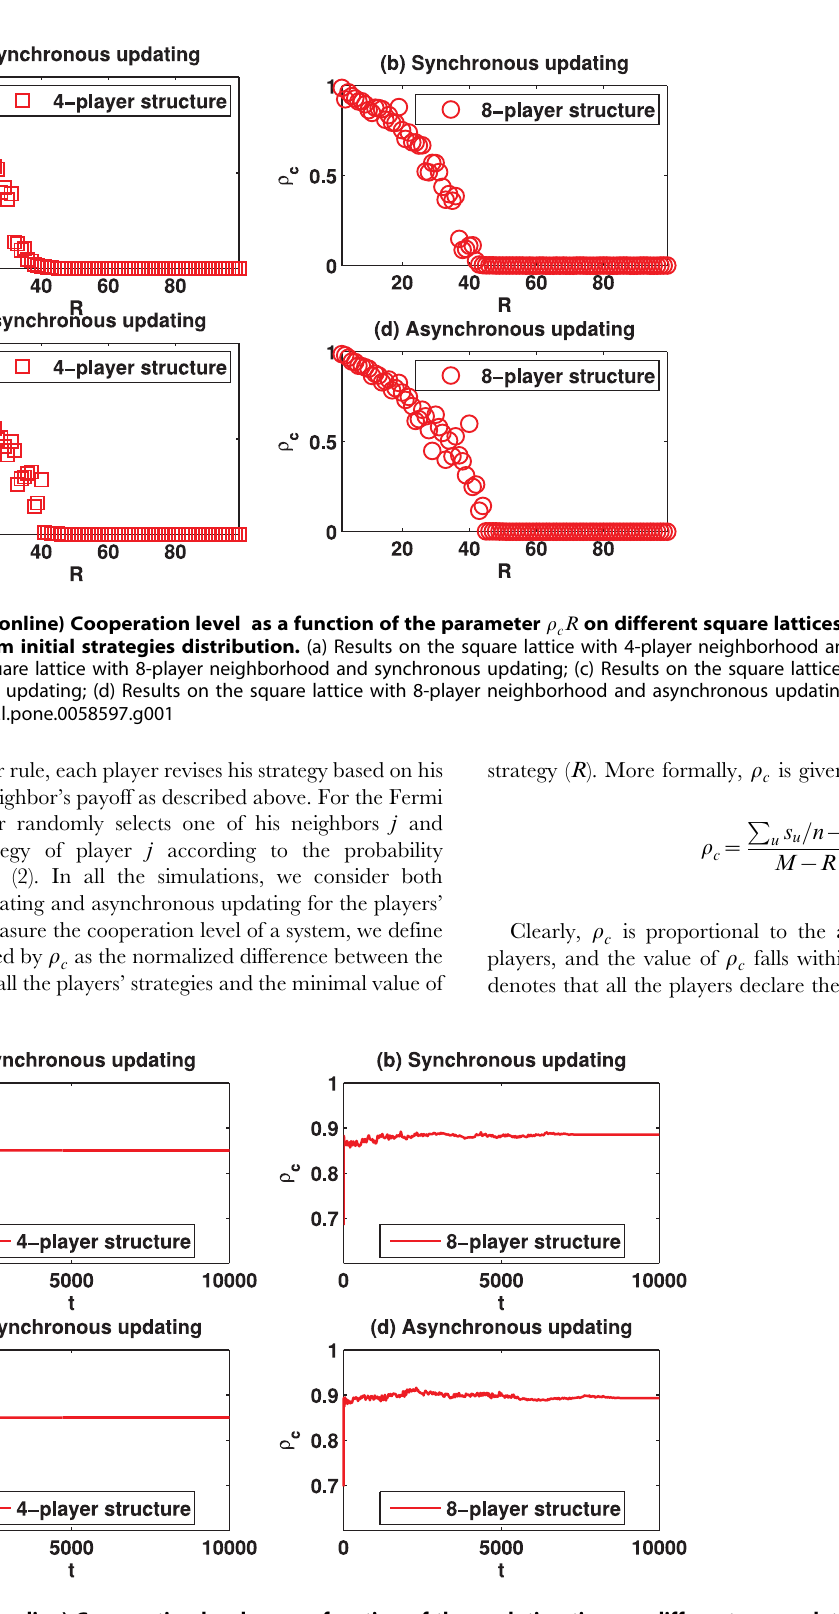
Figure 2. (Color online) Cooperation level r c as a function of the evolution time on different square lattices under the best-take- over rule given that R ~ 10 . (a) Results on the square lattice with 4-player neighborhood and synchronous updating; (b) Results on the square lattice with 8-player neighborhood and synchronous updating; (c) Results on the square lattice with 4-player neighborhood and asynchronous updating; (d) Results on the square lattice with 8-player neighborhood and asynchronous updating.